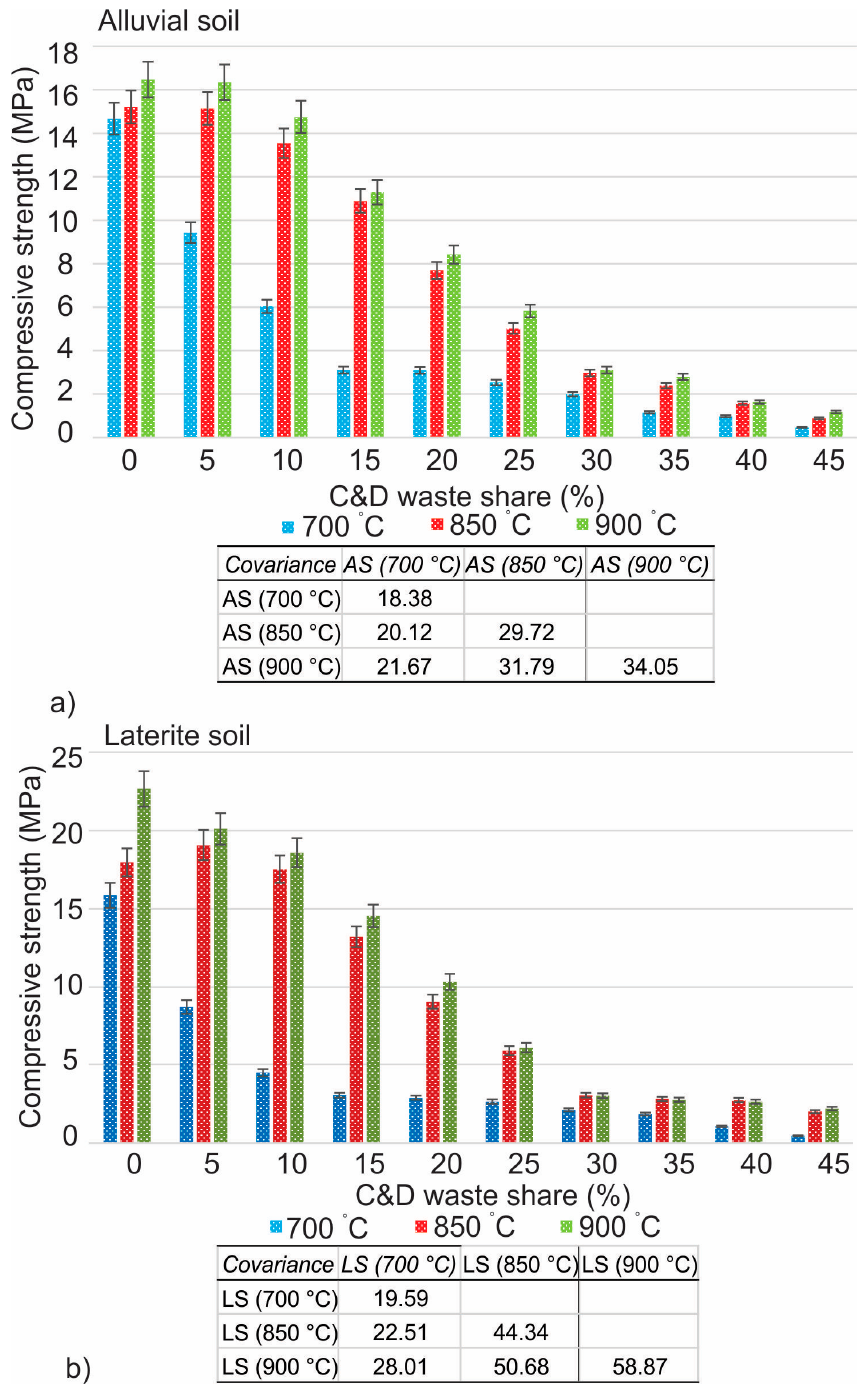
Figure 7. Compressive strength of mixed C&D waste in alluvial ( a ) and laterite ( b ) soils. The findings of firing linear shrinkage are provided in Figure 8, while the results of loss on ignition and bulk density are represented in Figures 9 and 10, respectively. There is a subsequent decrease in density that takes place whenever mixed C&D waste is inte- grated into any of the soils at any one of the three temperatures. The decrease in bulk density of the fired brick specimens at a temperature of 700 °C varied from 1435 g/cm 3 to 1382 g/cm 3 in laterite soil and from 1473 g/cm 3 to 1444 g/cm 3 in alluvial soil for 0% to 10% addition of the mixed C&D waste. The bulk density, on the other hand, decreased from 15% to 45% with the addition of C&D waste in the soil, revealing 1311 g/cm 3 to 1237 g/cm 3